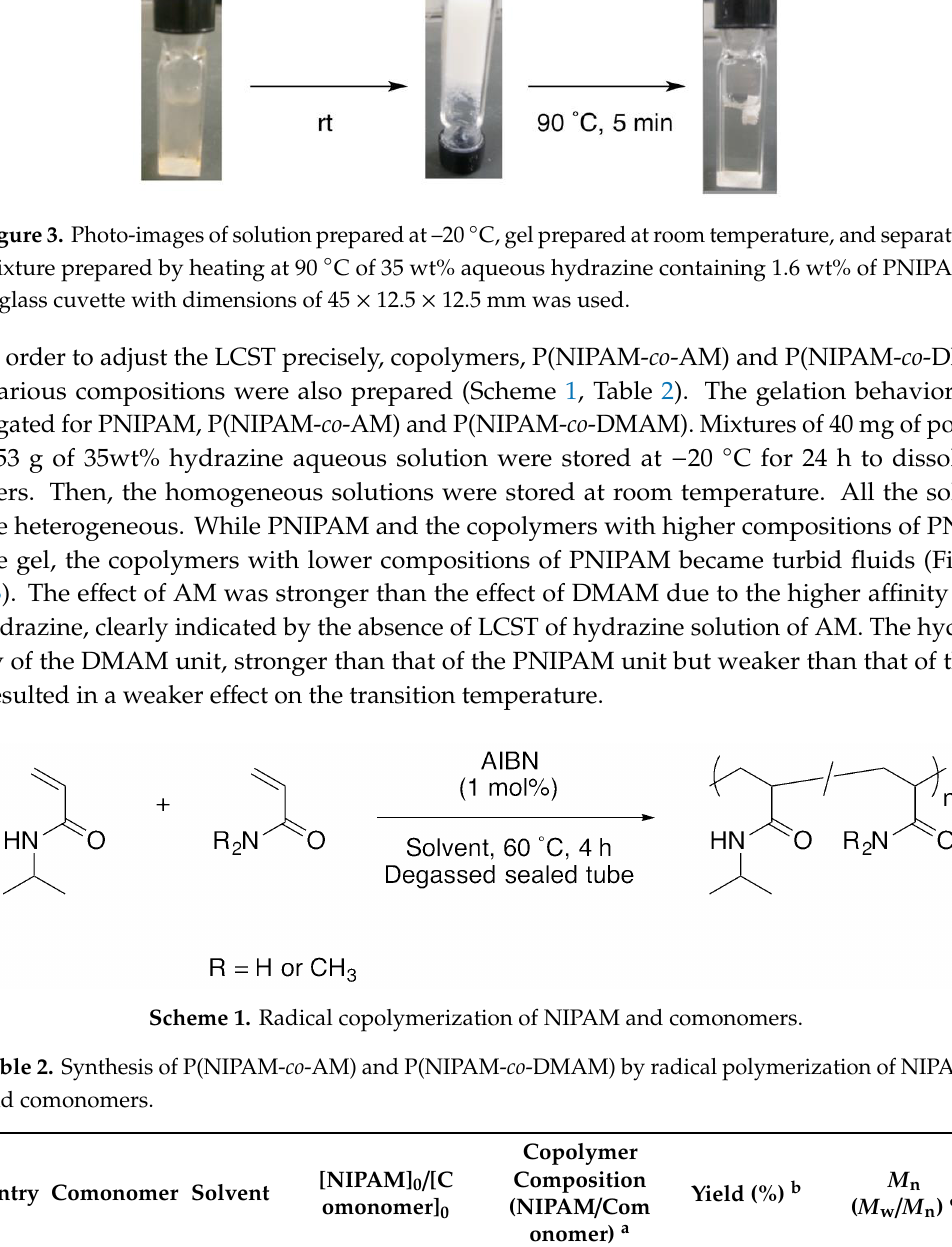
Figure 3. Photo-images of solution prepared at –20 °C, gel prepared at room temperature, and separated mixture prepared by heating at 90 °C of 35 wt% aqueous hydrazine containing 1.6 wt% of